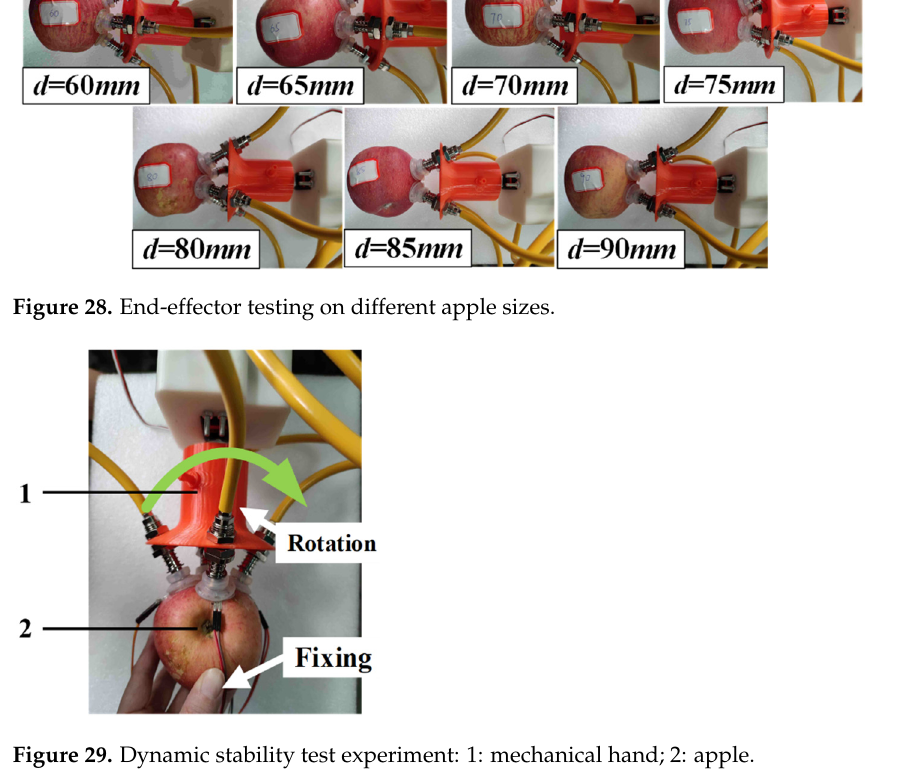
Figure 29. Dynamic stability test experiment: 1: mechanical hand; 2: apple.